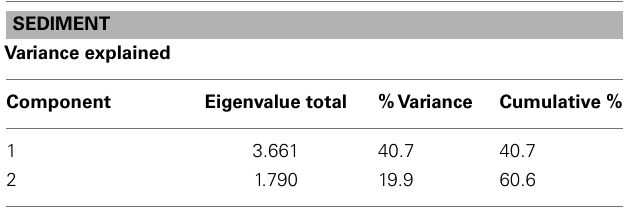
TableA2 | Principal component analysis ofARG abundances in sediment and water column